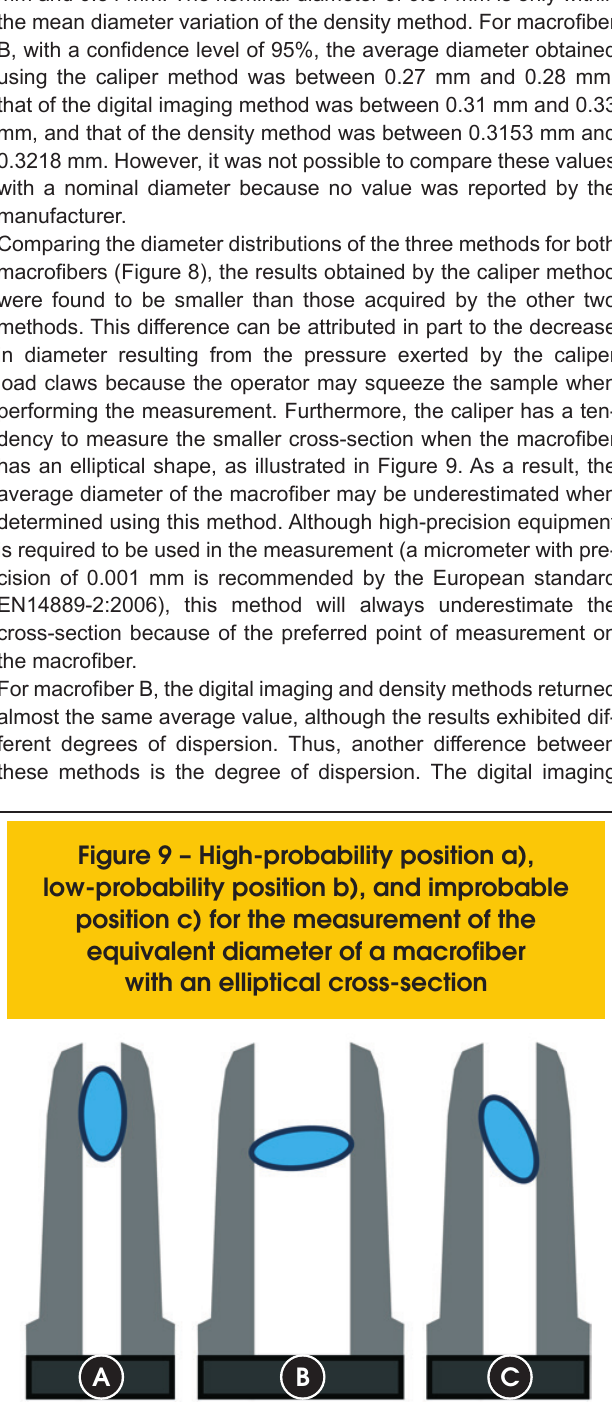
Figure 8 – Distribution curves of the diameters of macrofibers A and B according to the three methods